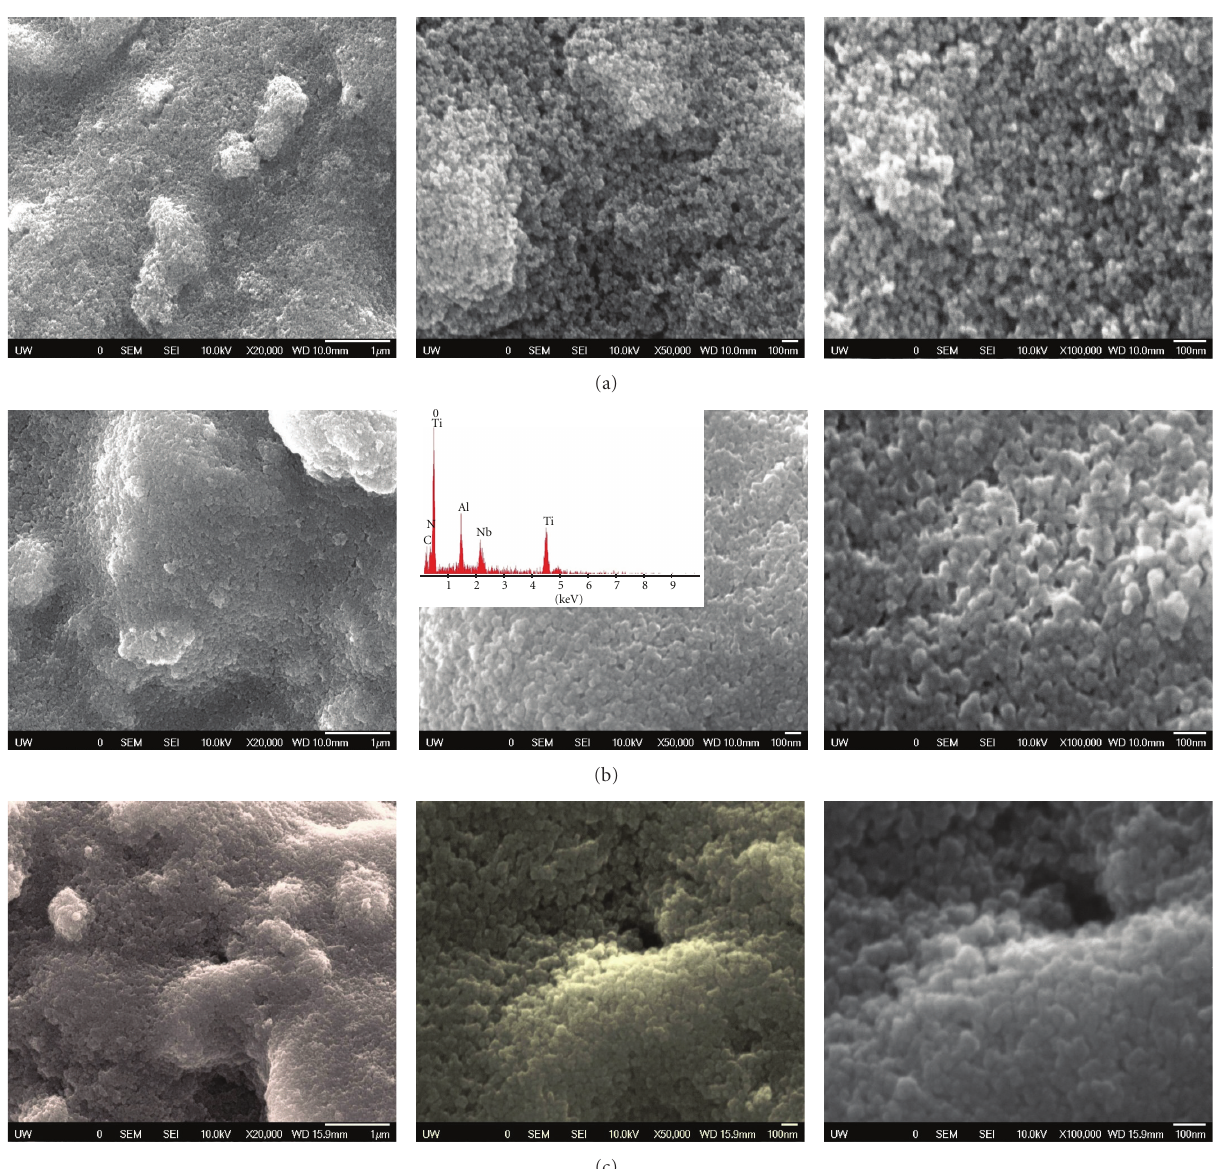
Figure 2: SEM images of the surface of (a) uncoated Nb:TiO 2 films, for Nb :TiO 2 layer treated with 10 cycle of ALD of (b) alumina and (c) hafnia. The index of (b) showed the EDX spectrum of the